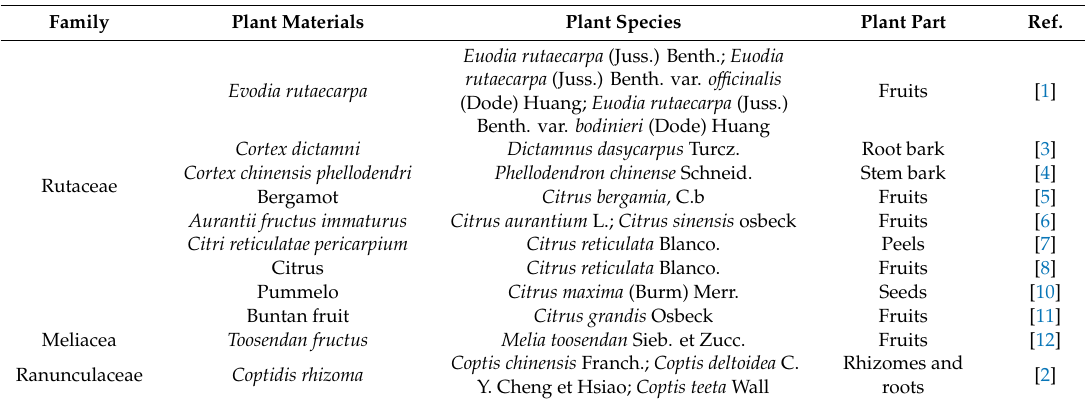
Figure 1. Chemical structure of limonin. Table 1. Plants containing